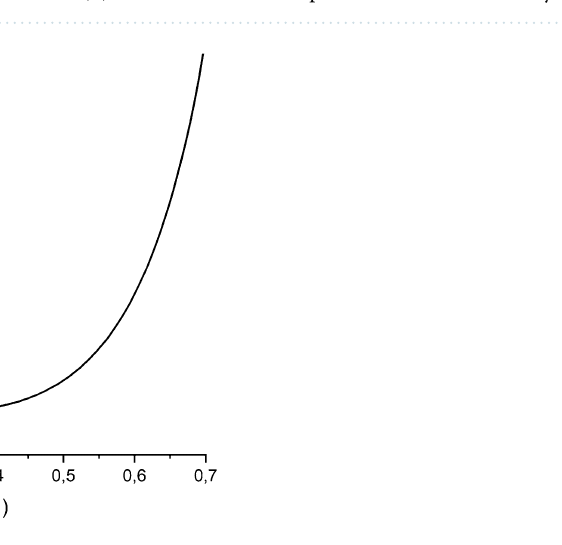
Figure 3. ( a ) Computer simulation of the BSV-23 Cu X-ray tube. Red lines are accelerated electrons and green lines are photons. ( b ) The spectrum of photons N(E) in arb. units at the output of the BSV-23 Cu X-ray tube.